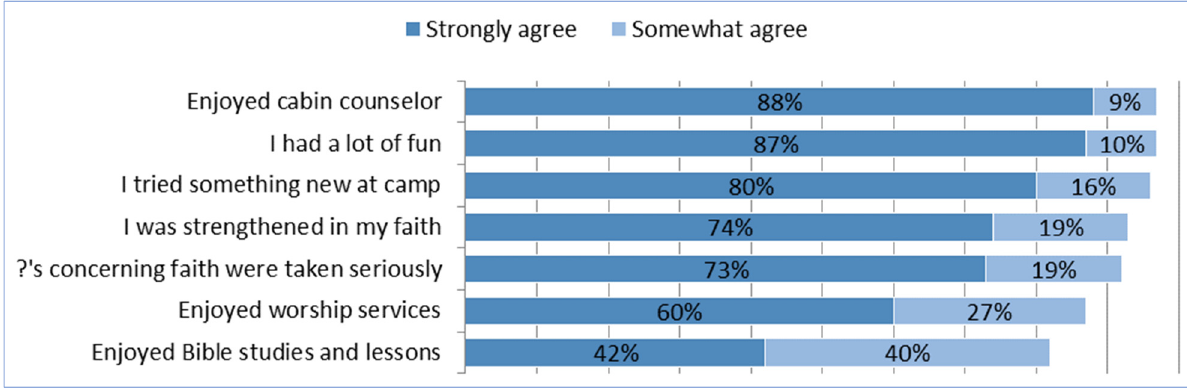
Figure 2. Examples of Camper Impressions of the Camp Experience, Last Day (N =